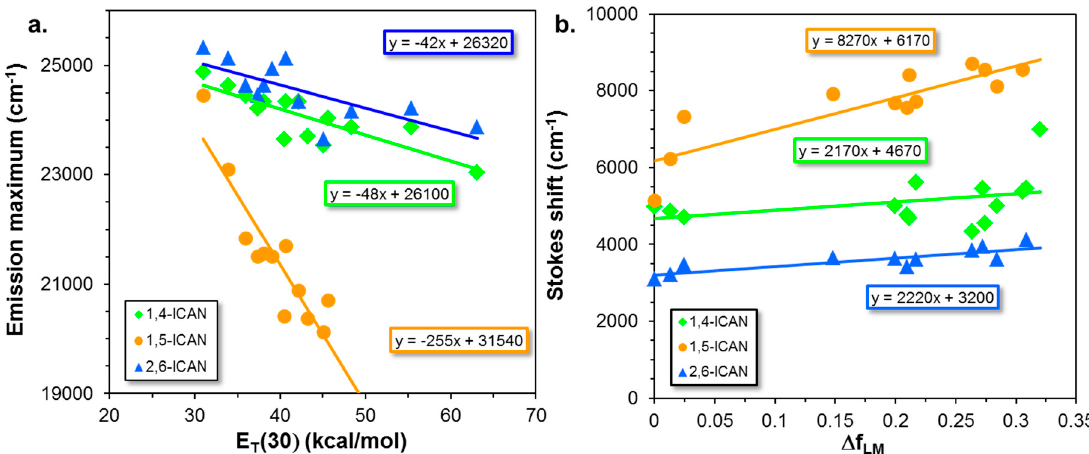
Figure 4. Variation of the fluorescence emission maximum with the empirical solvent polarity parameter E T (30) ( a ), and the Lippert–Mataga (LM) ( b ), plots for the 1,4-ICAN, 1,5-ICAN, and the 2,6-ICAN isomers. The data for the 1,5-ICAN isomer are taken from ref [15].